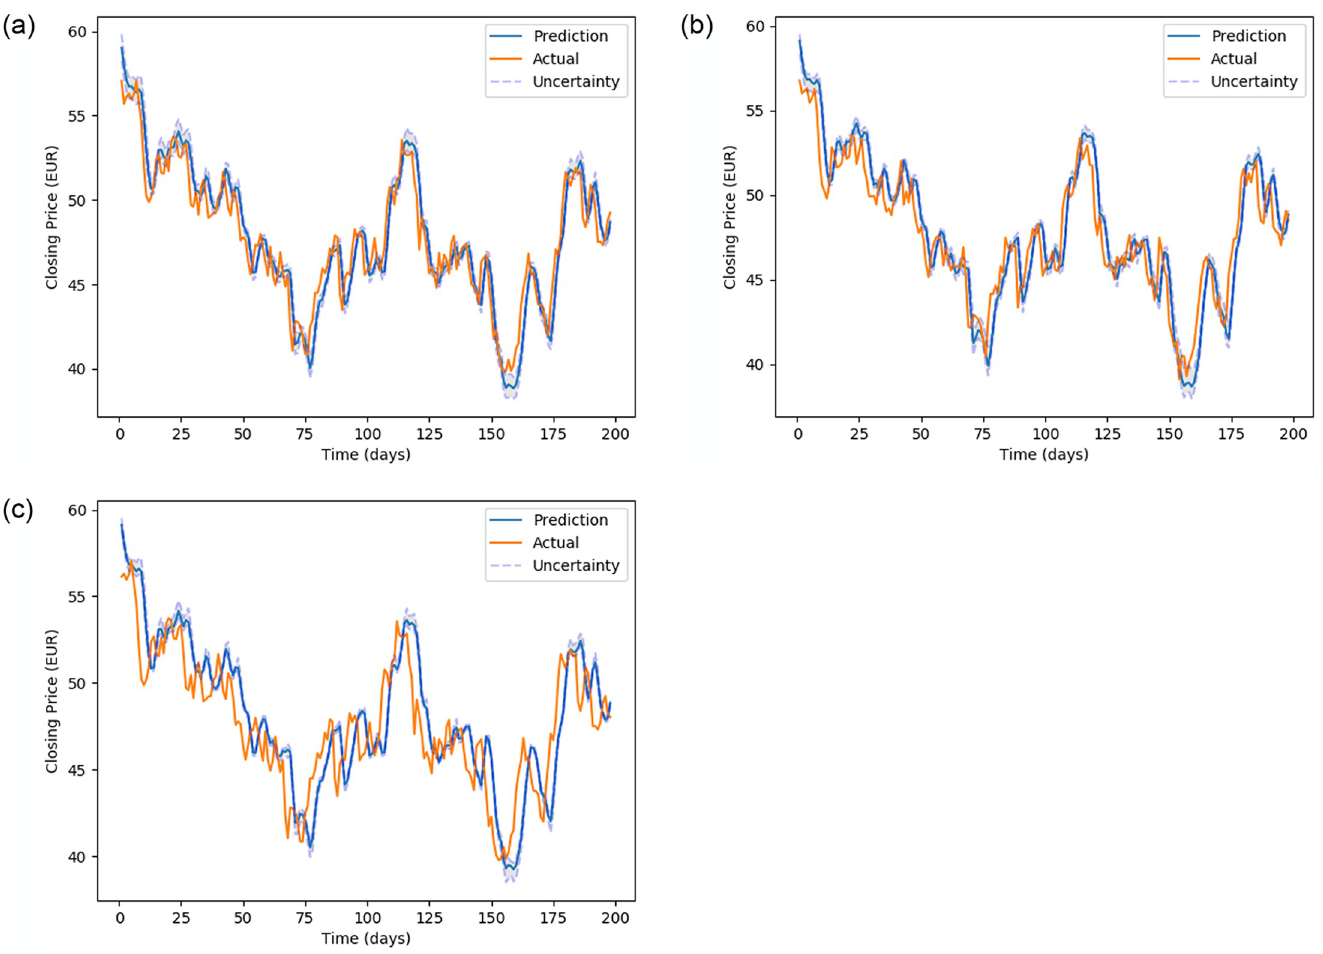
Fig 8. Prediction and uncertainty (shaded region) for test data of stock DAI.DE.